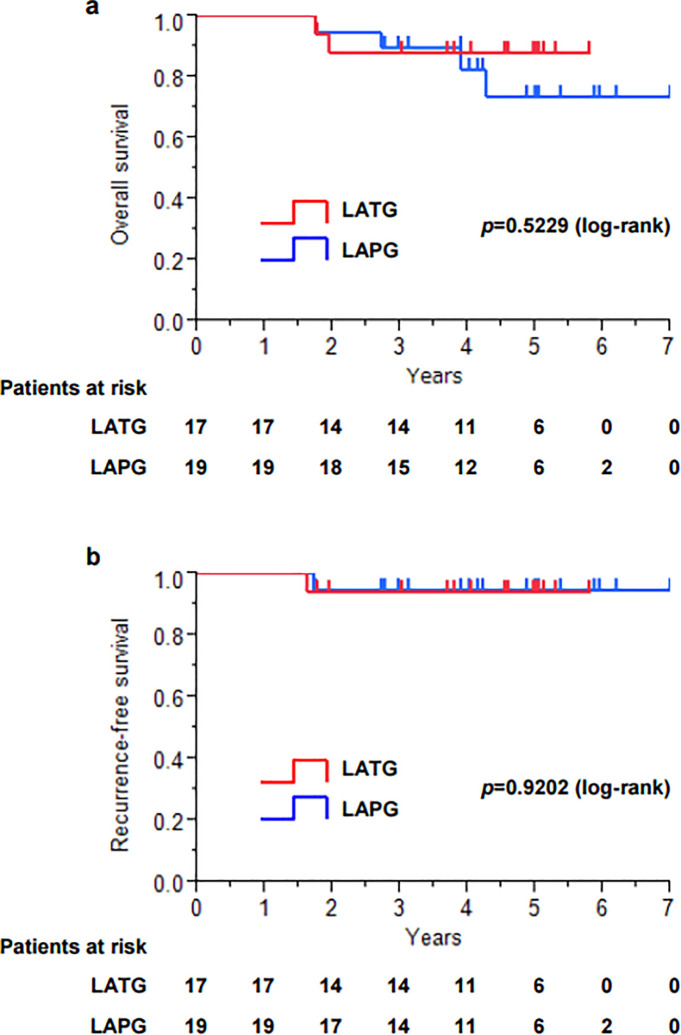
Kaplan-Meier survival analysis.a. Overall survival. b. Recurrence-free survival.